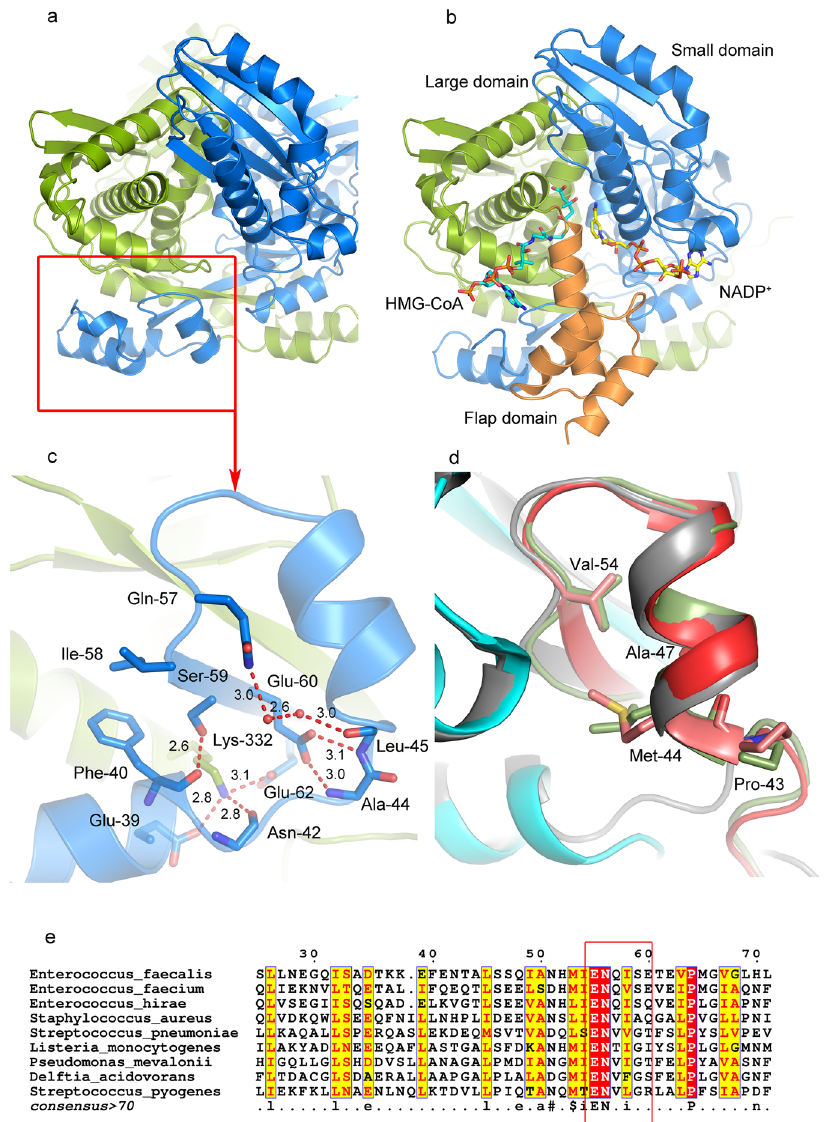
Fig. 1 efHMGR dimer architecture and domain swap. a The apo efHMGR dimer structure: Two monomers interact in an intricate fashion to form the biologically active dimer, colored green and blue respectively. The N-terminal domain that is swapped is indicated by a red square. b In the liganded efHMGR dimer, the fl ap domain (orange) closes upon binding of HMG-CoA and NADP + (represented as blue and yellow sticks). HMG-CoA primarily interacts with the large domain of one monomer (green) and NADP + interacts with small domain (blue) of the other monomer. c The ENQISX 3 VP loop, unique in efHMGR, participates in various interactions at the crossover point. The interacting residues (Gln-39, Phe-40, Asn-42, Ala-44, Leu-45, Gln-57, Ile-58, Ser-59, Glu-60, Glu-62 and Lys-332) are represented in sticks. The H-bonds are shown as red dashed lines and the distances are shown in Å. d The ENVIG loop in pmHMGR (green) and DaHMGR (red) shown in cartoon representation suggest that presence of a proline residue preceding this loop along with other hydrophobic residues such as Met-44, Ala-47 and Val-54 prevent a complete domain swap. The dimer partner is shown in cyan. The “ ENQIS loop ” of efHMGR (grey) is shown as a reference. e Multiple sequence alignment of efHMGR with class II HMGR sequences from S. pneumoniae , S. aureus , P. mevalonii , Listeria monocytogenes , Delftia acidovorans , E. faecium , E. hirae show that the ENQIS loop (in red box) is unique to